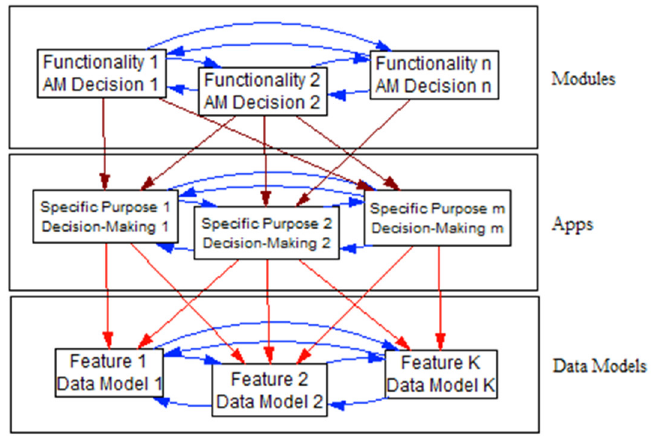
Figure 2. Structure of Apps at the software as a service (SaaS) level.